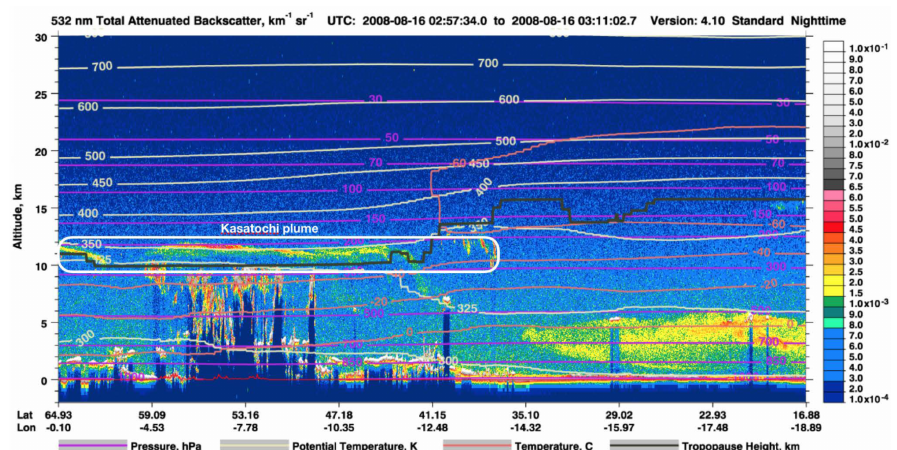
Figure 24. Caliop browse image showing location of the Kasatochi plume. The black line indicates the position of the tropopause